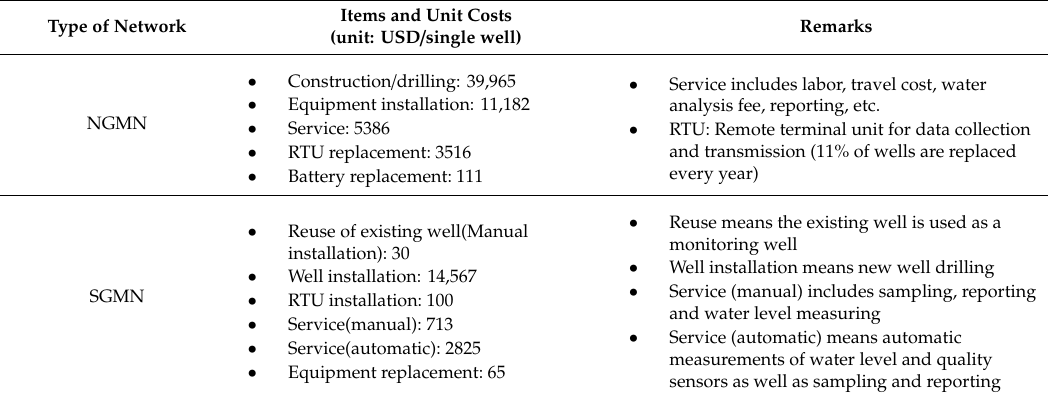
Table 4. Unit costs of construction and management for groundwater monitoring